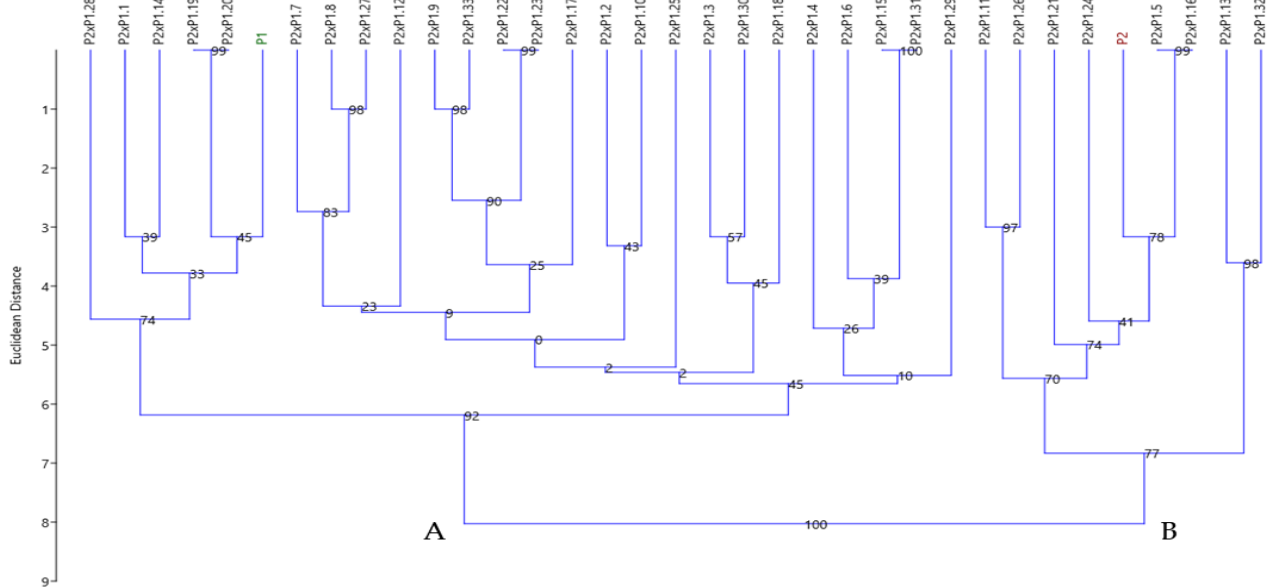
Figure 8. UPGMA dendrogram generated by SCoT markers, showing the relationships between parents (P1 and P2) and F 1 plants from P2×P1 cross and based on Euclidean’s distance index. Numbers on the branches show bootstrap values, computed from 10,000 replications. In dendrogram, the mother parent is marked with red color, while the father parent is marked with green color.